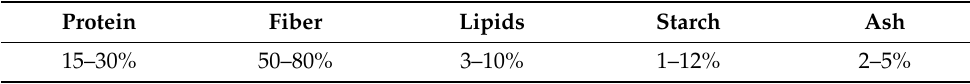
Table 1. Composition of brewer’s spent grain